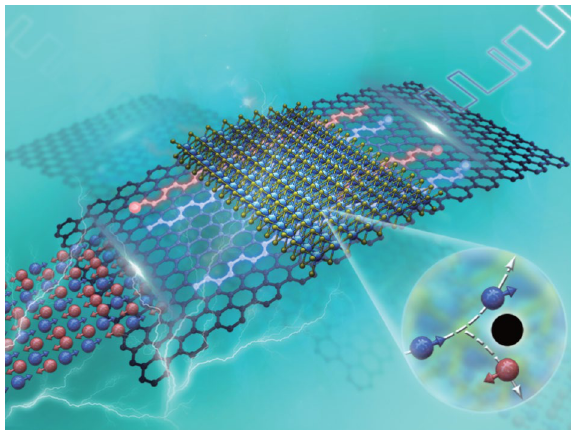
Fig. 10 Schematic of the spintronics based on 2D materials. Elec‑ trons can be injected into 2D materials to generate spin current (the colors present the different spin) by electrical or optical injection, in which the electrons with different spins diffuse in the opposite direc‑ tion. The spin could be manipulated by the interface effect of the 2D heterostructure to produce logic signals. (Color figure